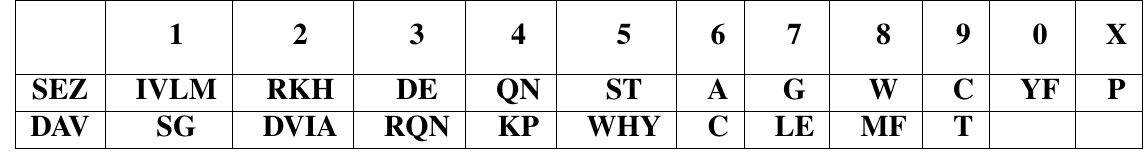
Table 1: Amino acid grouping